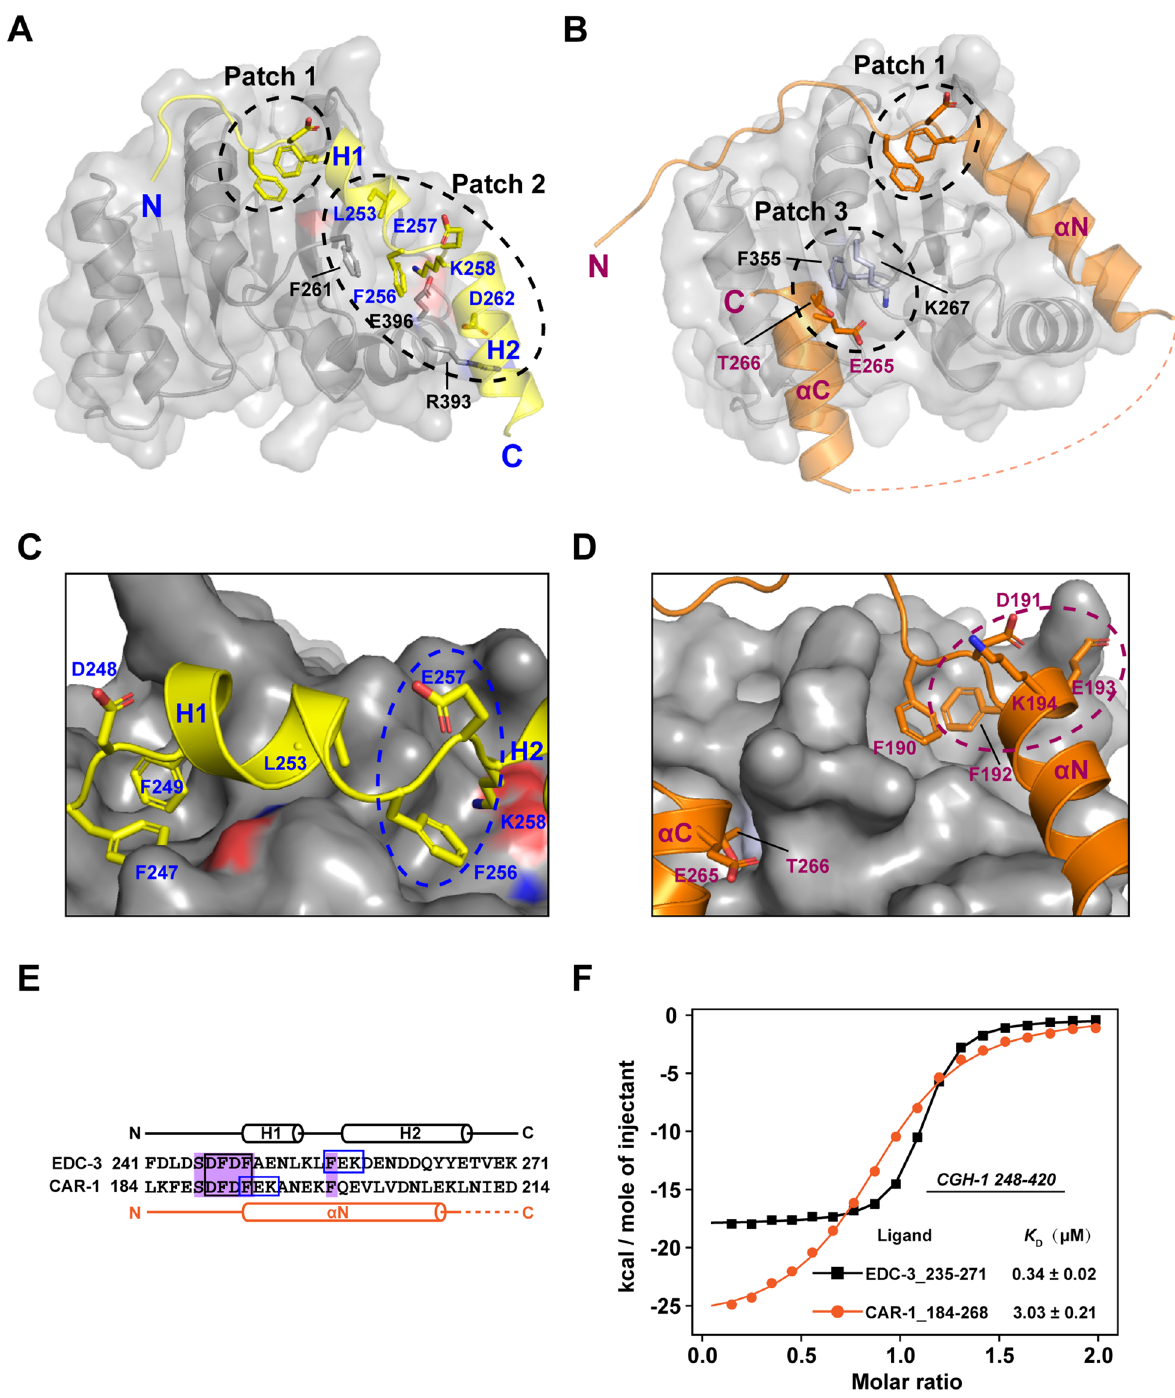
Figure 3. Similarity and differences of the binding mode of EDC-3 and CAR-1 for CGH-1. ( A ) The binding mode between CGH-1 RecA2 domain and EDC-3 FDF. Amino acids in the Patch 2 are represented by the side chains. ( B ) The binding mode between CGH-1 RecA2 domain and CAR-1 FDF-TFG. Amino acids in the Patch 3 are represented by the side chains. ( C ) EDC-3 FDF and FEK binding pocket. CGH-1 RecA2 domain is presented as a surface. FEK is marked with blue dotted ellipse. ( D ) CAR-1 FDF and TFG binding pocket. ( E ) Sequence alignment of EDC-3 241–271 and CAR-1 184–214 . The conserved residues SDFDF is marked with a pink box, and FEK is marked with a blue box. Second structures were shown on the top. ( F ) ITC curves: titrating EDC-3 235–271 and CAR-1 184–268 to CGH-1 248–420 , respectively. The ITC data for EDC-3 in Figs. 2C and 3F are the same